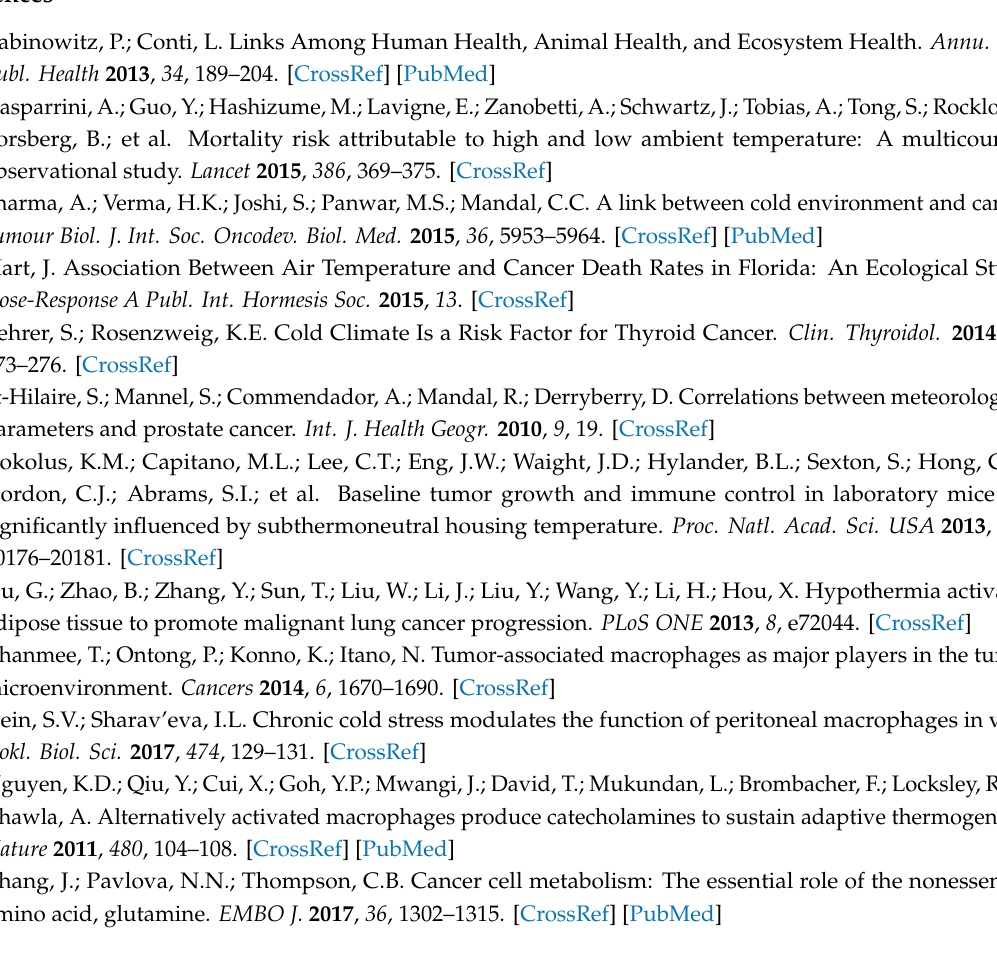
Figure S1. Ambient cold accelerated the growth of allograft melanoma B16F10 cells. Figure S2. The growth of cancer cells was enhanced by cold-exposed stromal cells. Figure S3. Glutamine contents in cold-exposed stromal cells. Figure S4. The e ff ect of glutamine or GPNA on the growth of cancer cells. Figure S5. The e ff ect of GPNA on the body weight and tumor growth in ambient cold conditions. Figure S6. The whole blot used in this study. Table S1: Potential metabolites in cold-exposed macrophages cultured media found by